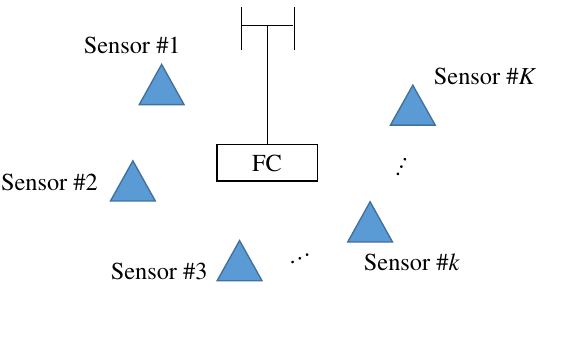
Figure 1. Overview of wireless sensor